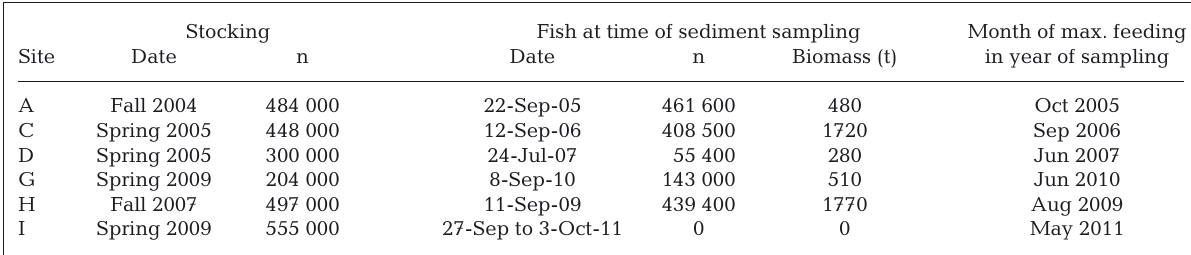
Table 2. The number of fish stocked per site and the number and biomass of fish at the time of sediment sampling. n = number of fish. Sites D and G were partially harvested at the time of sediment sampling, while Site I completed harvesting 5 d prior to sediment